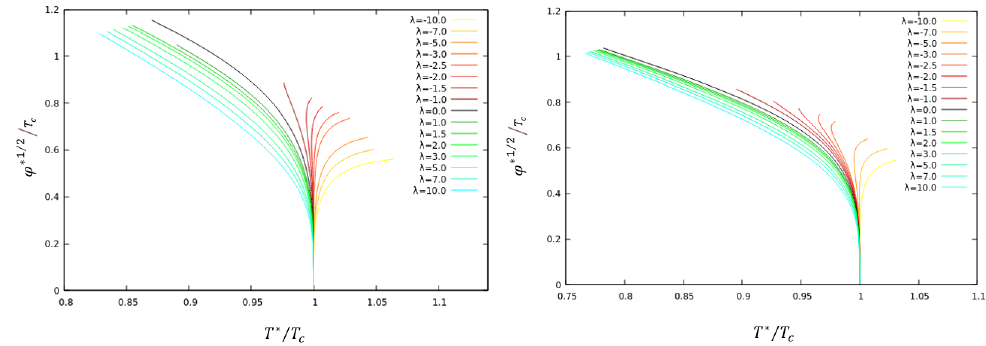
Figure 5. The condensate ϕ 1/2 + / T c for a balanced superconductor as a function of T / T c for several values of λ and (cid:101) = − 0.5 ( left ) and (cid:101) = 0.5 ( right ).